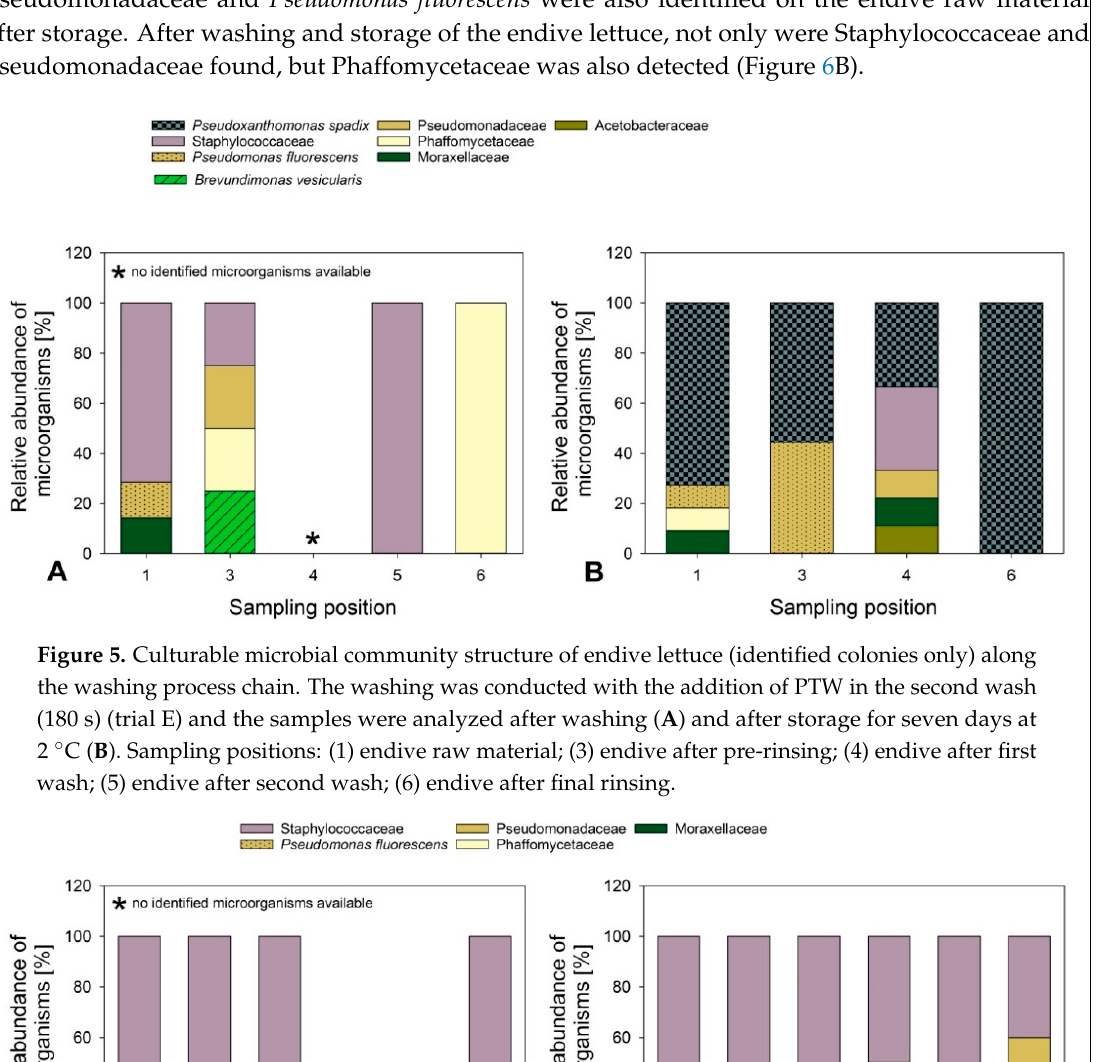
Figure 5. Culturable microbial community structure of endive lettuce (identified colonies only) along the washing process chain. The washing was conducted with the addition of PTW in the second wash (180 s) (trial E) and the samples were analyzed after washing ( A ) and after storage for seven days at 2 °C ( B ). Sampling positions: (1) endive raw material; (3) endive after pre-rinsing; (4) endive after first wash; (5) endive after second wash; (6) endive after final rinsing.